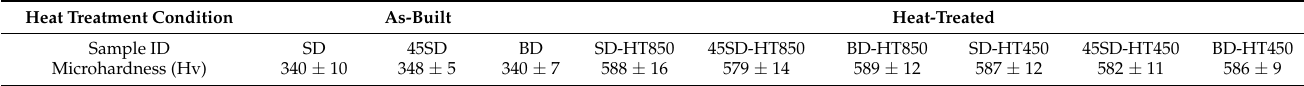
Table 4. Effect of building direction and heat treatment on the hardness of the maraging 18Ni-300 steel produced by LPBF. Heat Treatment